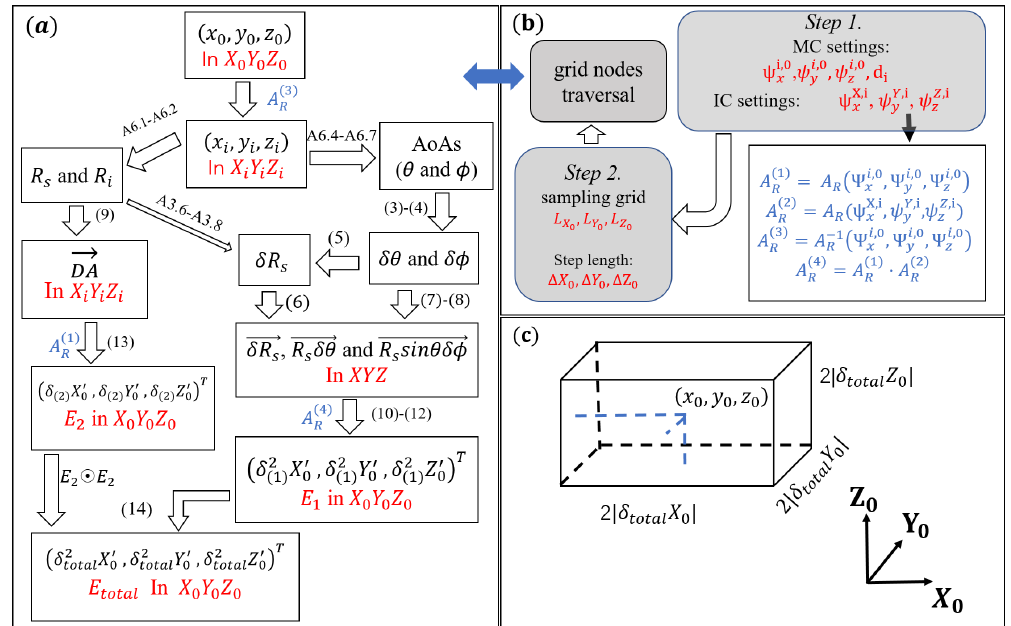
Figure 5. (a) The flow chart of the location error calculation process for a point in X 0 Y 0 Z 0 . The notation beside the arrows represents the corresponding equations (black) or coordinate rotation matrix (blue) in the paper. (cid:12) is the Hadamard product. Thus, E 2 (cid:12) E 2 will yield Z 0 ) T . (b) The flow chart of the program to calculate the location errors distributions for a radar link L i . This process Y 0 ,δ 2 X 0 ,δ 2 (δ 2 ( 2 ) ( 2 ) ( 2 ) includes parameters settings for a radar link, the generation of the sampling grid nodes and the traversing of all the nodes. For each node, the program uses the calculation method described in (a) . MC is the multistatic configuration, and IC is the interferometer (receiving antenna) configuration. (c) Schematic diagram of the relationship between the spatial resolution and the total location errors of the MTSP. For a detected point in space, the MSE of MTSP’s location errors is ±| δ total X 0 | , ±| δ total Y 0 | and ±| δ total Z 0 | in the zonal, meridional and vertical directions, respectively. This means that the actual specular point might occur in a region that forms a 2 | δ total X 0 |× 2 | δ total Y 0 |× 2 | δ total Z 0 | cube and that the detected point is on the centroid of this